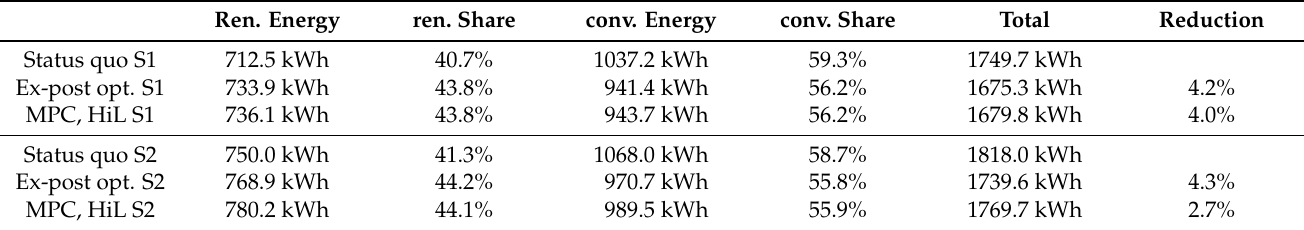
Table 3. Energy from utility grid: Renewable energy (ren.), renewable energy share from grid, conventional energy (conv.), conventional share from grid, total energy from grid and reduction of utility-grid energy due to increased DER own consumption in ex-post optimal case and MPC controlled case (HiL-experiment) for both scenarios. Ren. Energy ren. Share conv. Energy conv. Share Total Status quo S1 712.5 kWh